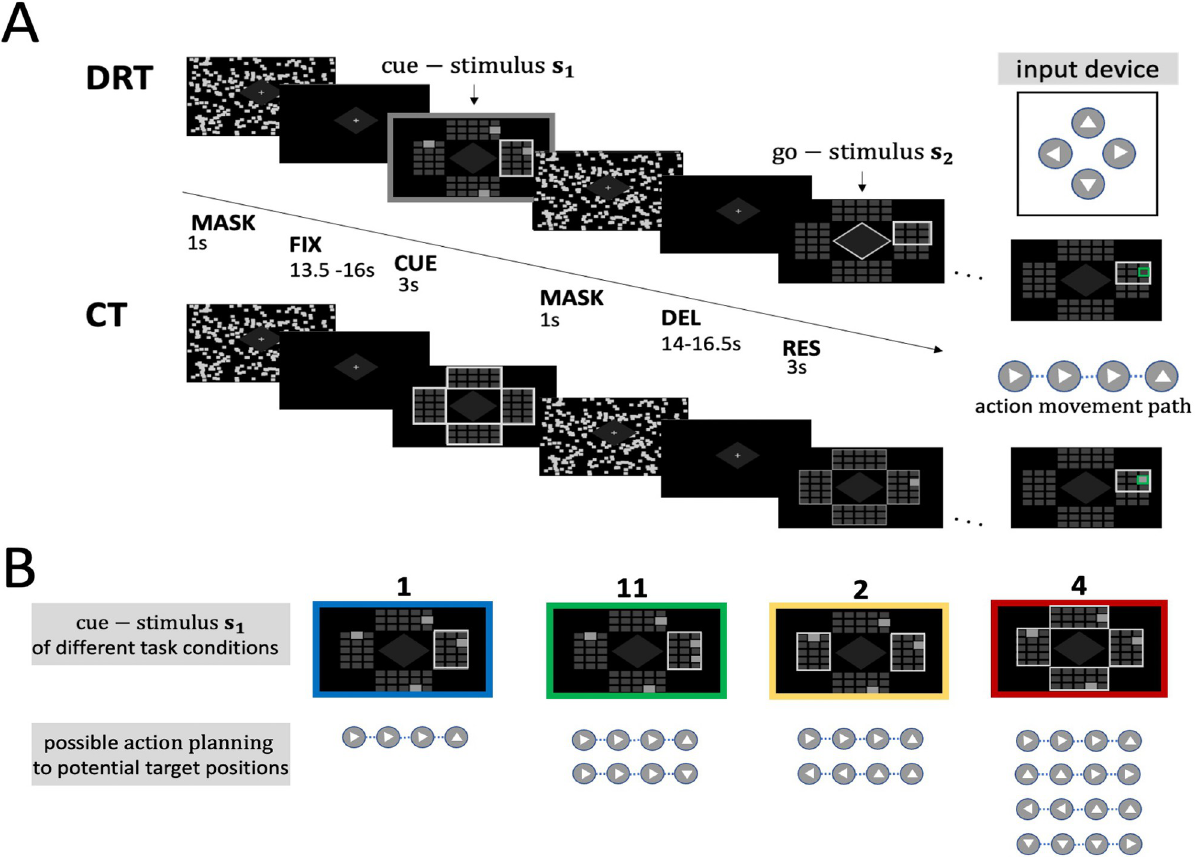
Fig 1. Experimental task design. (A) Trials of the motor planning conditions in the delayed response task (DRT) and control condition (CT) were randomized and had a similar timeline. Each trial started with a fixation period (FIX) of random duration, a cue phase (CUE), where a cue-stimulus s 1 was presented, followed by a random dot pattern to mask afterimages of the CUE (MASK), a delay phase (DEL) of random duration for planning, and a response phase (RES). In the response phase (RES) the ultimate target location was revealed by a go-signal s 2 , namely a single grey frame around the relevant (part of the) respective response panel. Response trajectories were generated by subjects’ button presses on the illustrated input device. In the control task, no potential target cues were presented during the cue phase and therefore no goal-directed actions could be planned during the delay phase. In the response phase of the CT subjects were finally informed about the target location (single grey box). (B) The four target planning conditions differed in the number of potential target locations initially cued. Subjects could see possible target positions highlighted (grey boxes). Potential targets to consider for planning were indicated by a grey frame around the field areas encompassing the relevant possible targets. Subjects were instructed to plan a single movement sequence towards one target (‘1’), two partially overlapping sequences towards two potential targets (‘11’), two distinct movement sequences towards two potential targets in different panels (‘2’), or four distinct movement sequences towards four potential targets (‘4’) respectively and to execute the planned goal-directed movement as sequential button presses with the right thumb in the following phase, after the ultimate target was revealed by the go-signal. During the DEL phase, preparation for a goal-directed action could follow a serial memory-based planning strategy (null hypothesis H 0 : “delayed planning”), or a concurrent prospective planning strategy (hypothesis H 1 : “concurrent prospective planning”) where possible planning of actions as movement paths to each of the potential target locations could be